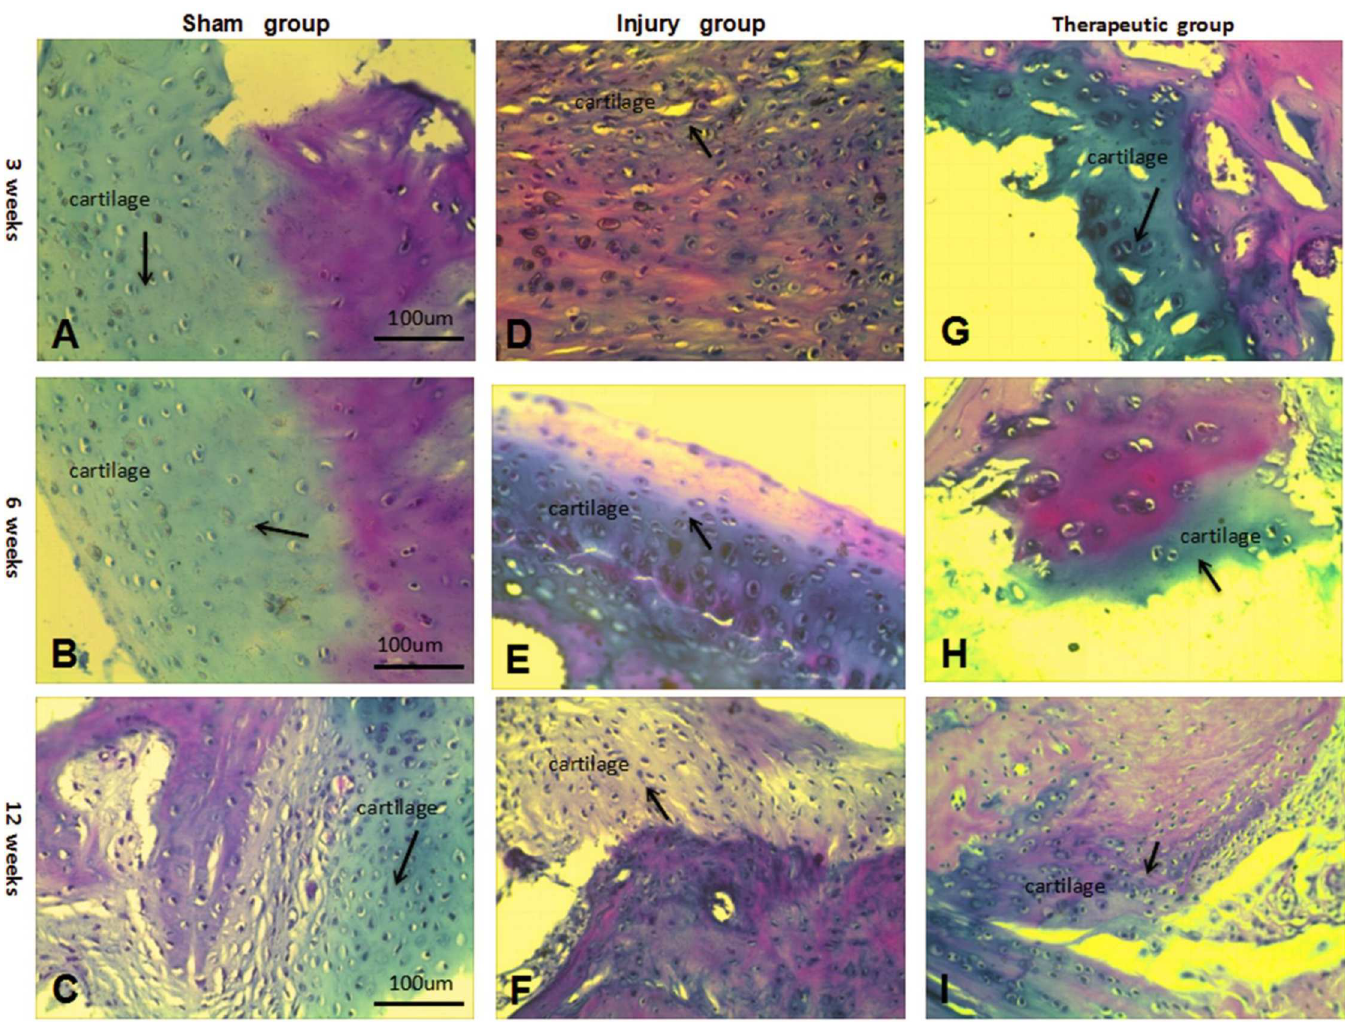
Fig 5. AB-PAS staining in each group after 3,6,12 weeks. (A-C) AB-PAS staining in the sharm group after 3,6,12 weeks ( × 100). (D-F) AB-PAS stainingin the injury group after 3,6,12 weeks ( × 100).(G-I) AB-PAS staining in the therapeutic groupafter3,6,12 weeks ( × 100). Black arrows:cartilage